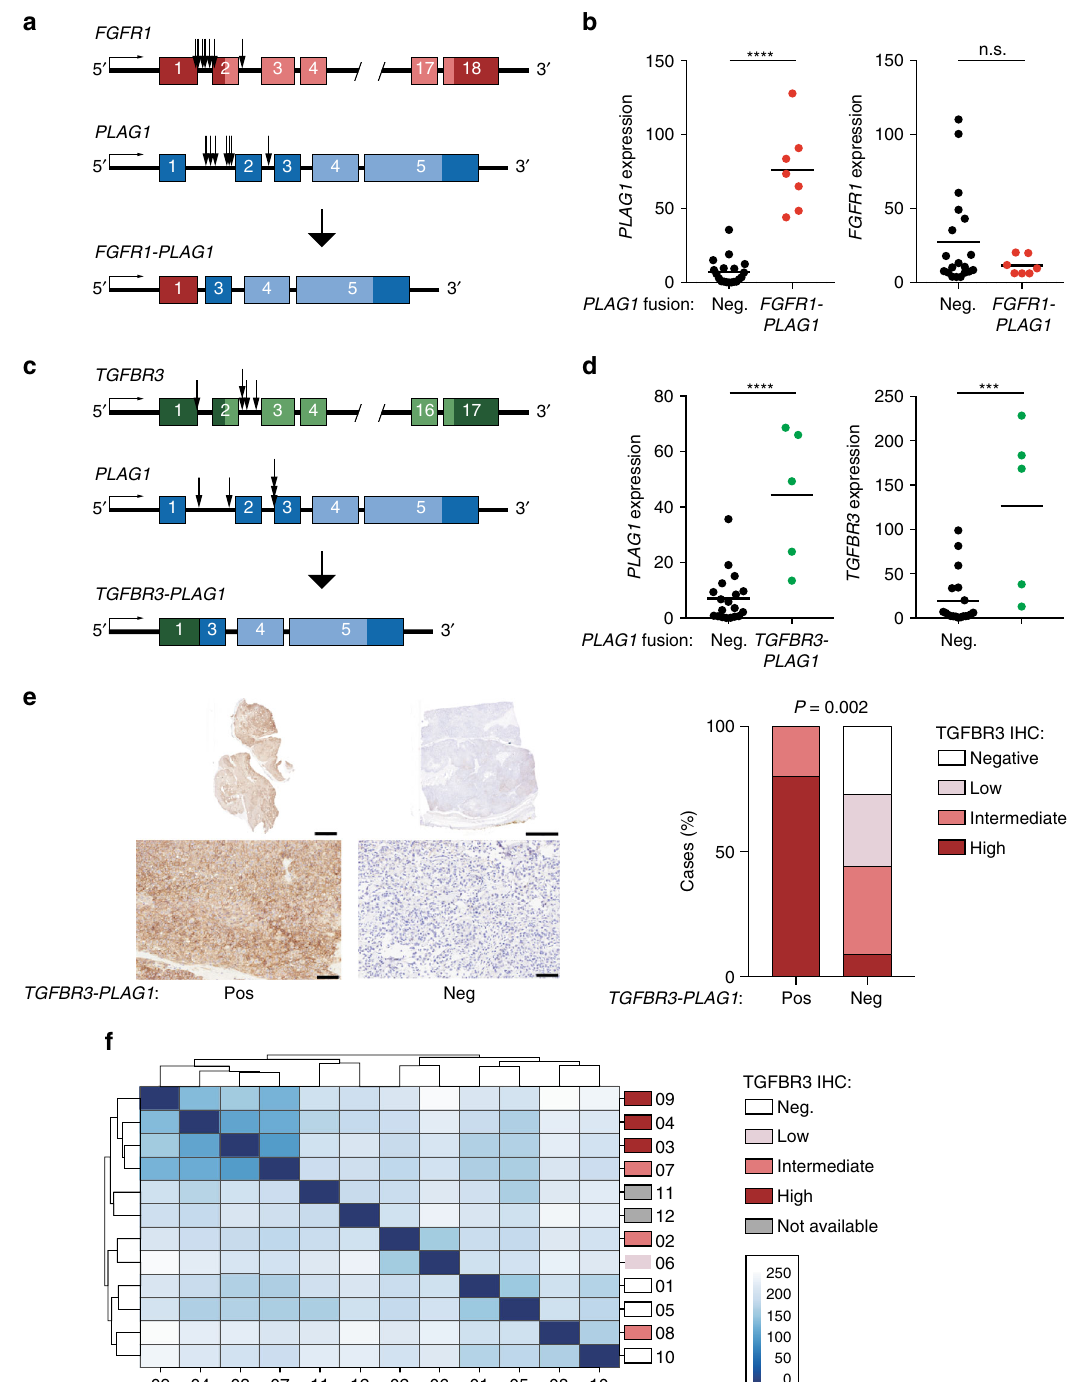
Fig. 2 Detection of the FGFR1-PLAG1 and TGFBR3-PLAG1 fusion genes. a Illustration of the FGFR1-PLAG1 fusion gene. Arrows show locations of genomic break points for each of the tumors. b Expression of PLAG1 (left) and FGFR1 (right) in PLAG1 fusion-negative vs. FGFR1-PLAG1 -positive tumors. Graphs show fragments per kilobase of exon per million fragments mapped (FPKM), based on RNA-seq data. **** P < 0.0001; Student ’ s t -test. n = 19 + 7. Horizontal lines show mean values. c Illustration of the TGFBR3-PLAG1 fusion gene. d Expression (FPKM) of PLAG1 (left) and TGFBR3 (right) in PLAG1 fusion-negative vs. TGFBR3-PLAG1 -positive tumors. *** P < 0.001, **** P < 0.0001; Student ’ s t -test. n = 19 + 5. Horizontal lines show mean values. e Left, IHC showing TGFBR3 staining in whole tumor sections (upper panels, scale bars = 5 mm) and enlargement of selected areas (lower panels, scale bars = 100 μ m). Right, quanti fi cation of IHC TGFBR3 levels in TGFBR3-PLAG1 positive vs. negative tumors. P (high TGFBR3) = 0.002, Fisher ’ s exact test. n = 5 + 34. f Poisson sample clustering based on gene expression in cohort 1, annotated by TGFBR3 IHC